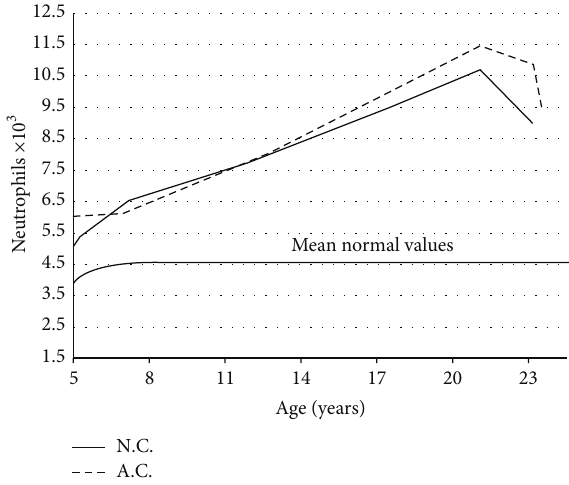
Figure 1: Neutrophil levels of the two patients during the